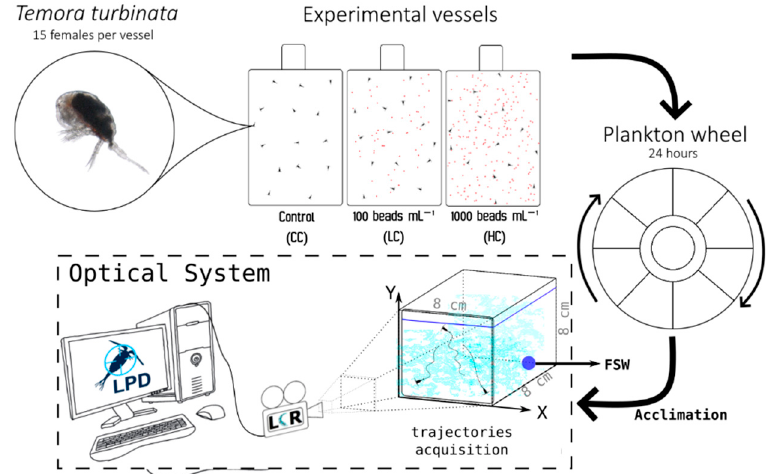
Figure 1. Schematic representation of the experimental setup. CC = Control (with I. galbana only); LC = low concentration ( I. galbana plus 100 beads mL − 1 ); HC = high concentration ( I. galbana plus 1000 beads mL − 1 ). FSW refers to filtered seawater. LCR (LAPS Camera Recorder) and LPD (LAPS Plankton Detector) are in-house software designed for image acquisition and trajectory extraction, respectively. Image frames were acquired as bidimensional projections (X, Y).